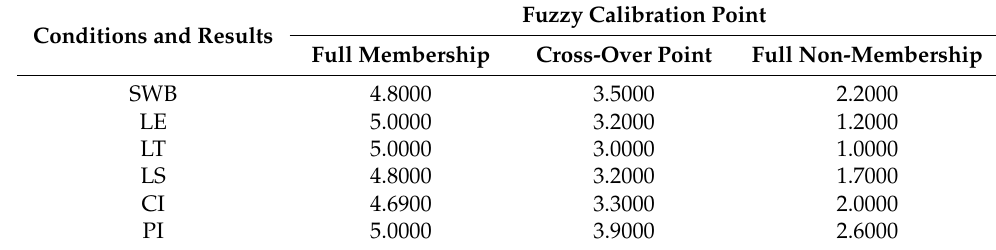
Table 8. The variable calibration.